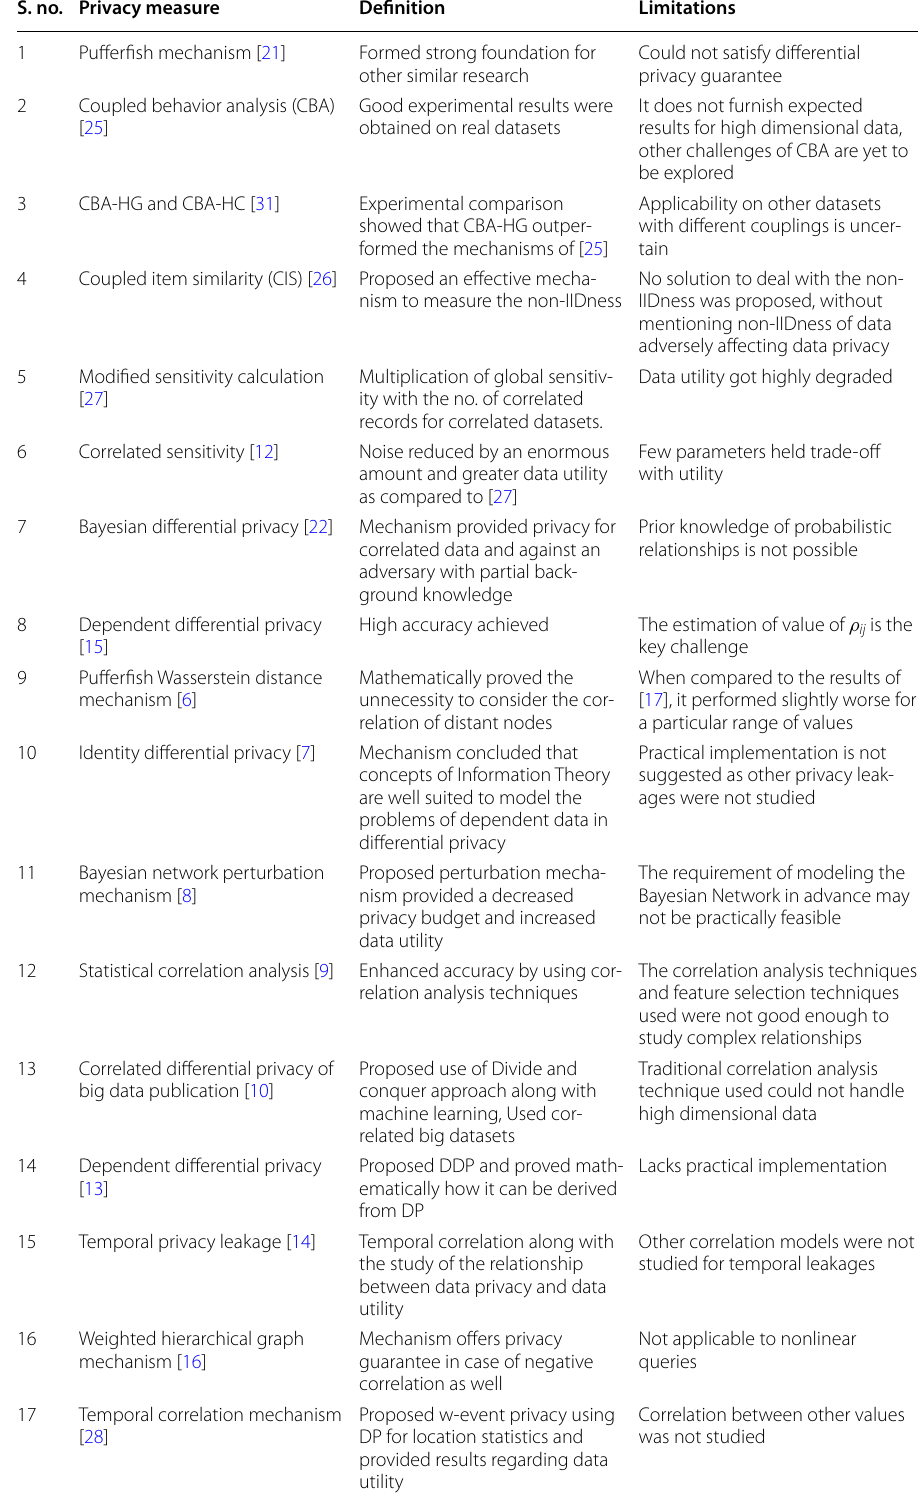
Table 2 Proposed